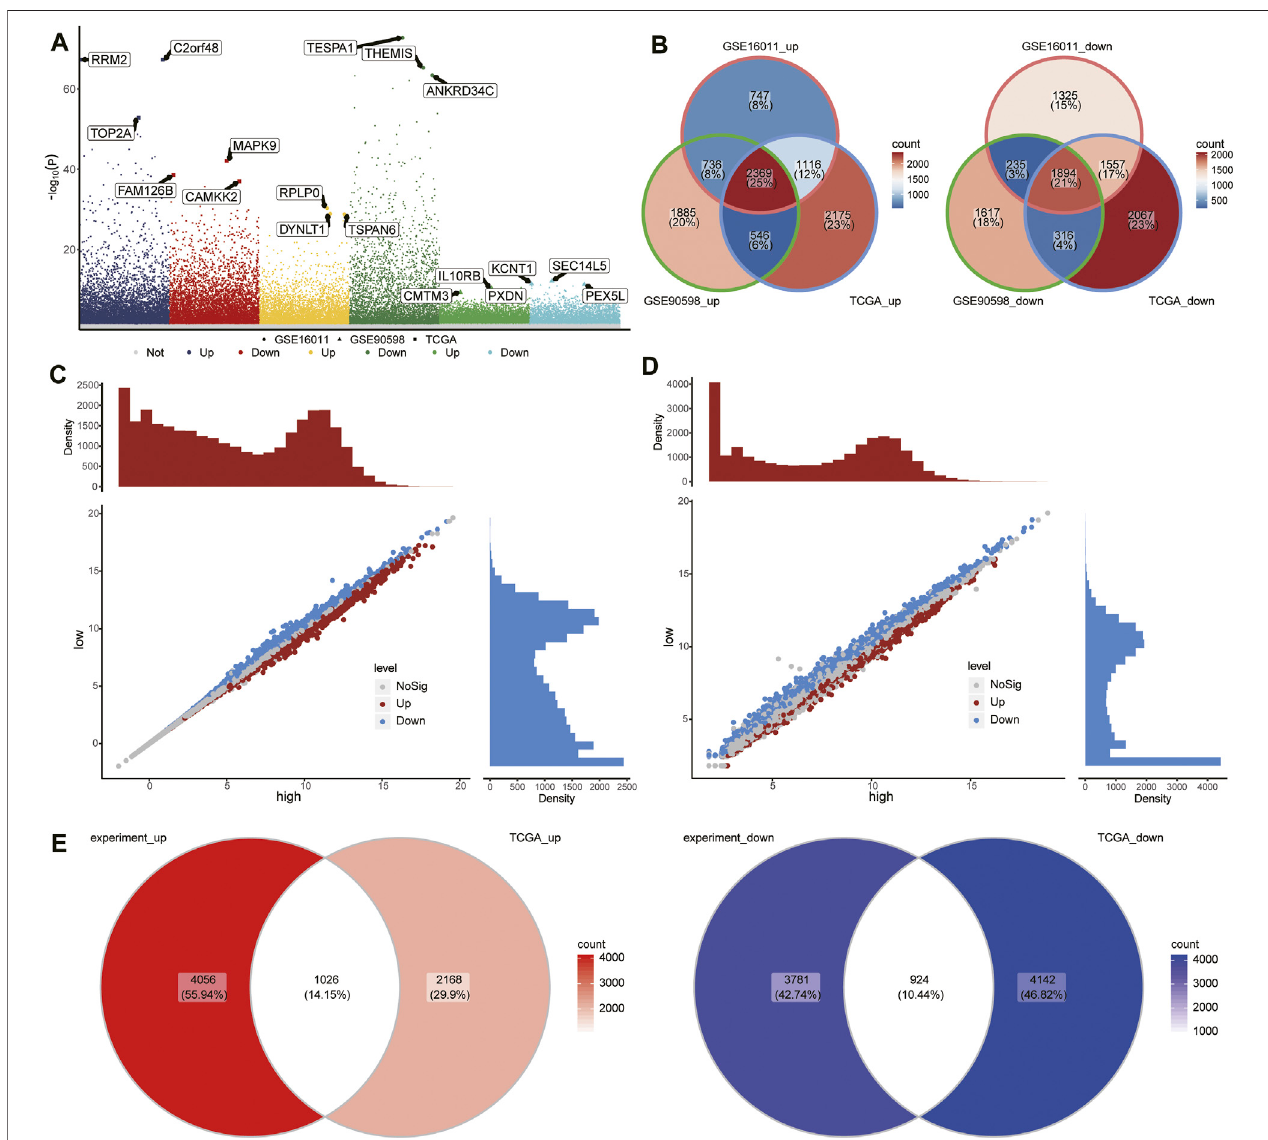
FIGURE 3 | Differentially expressed mRNAs (DEmRs) between the RBM8A high and RBM8A low groups. (A) Manhattan plot of DEmRs in TCGA, GSE16011, and GSE90598. The top 3 genes with the largest fold change in differential expression were labeled. (B) Intersection of DEmRs up- or downregulated across all three datasets. (C) DEmRsbetweenRBM8A-overexpressingT98GcellsandcontrolT98Gcells. (D) DEmRsbetweenRBM8A high andRBM8A low groupsinTCGA. (E) Overlap between the DEmRs in panels (C,D) consider as common